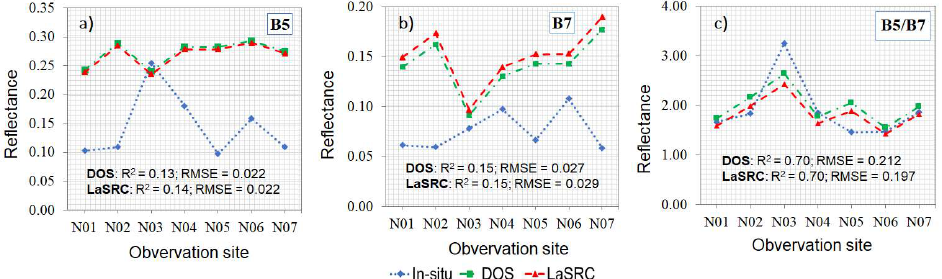
Figure 7. Comparisons of in situ R rs ( λ ) and retrieved R rs ( λ ) corresponding to ( a ) the L8 NIR band (band 5: B5), ( b ) the L8 SWIR-2 band (band 7: B7), and ( c ) the spectral ratio corresponding to B5/B7, obtained via two atmospheric correction methods: DOS and LaSRC. While the retrieved R rs ( λ ) of B5 and B7 indicates significant biases with respect to in situ R rs ( λ ), the retrieved B5/B7 ( c ) demonstrates a smaller dependency of the data on atmospheric correction, and it is consistent with in situ data, and therefore suitable for use in SMC estimation.